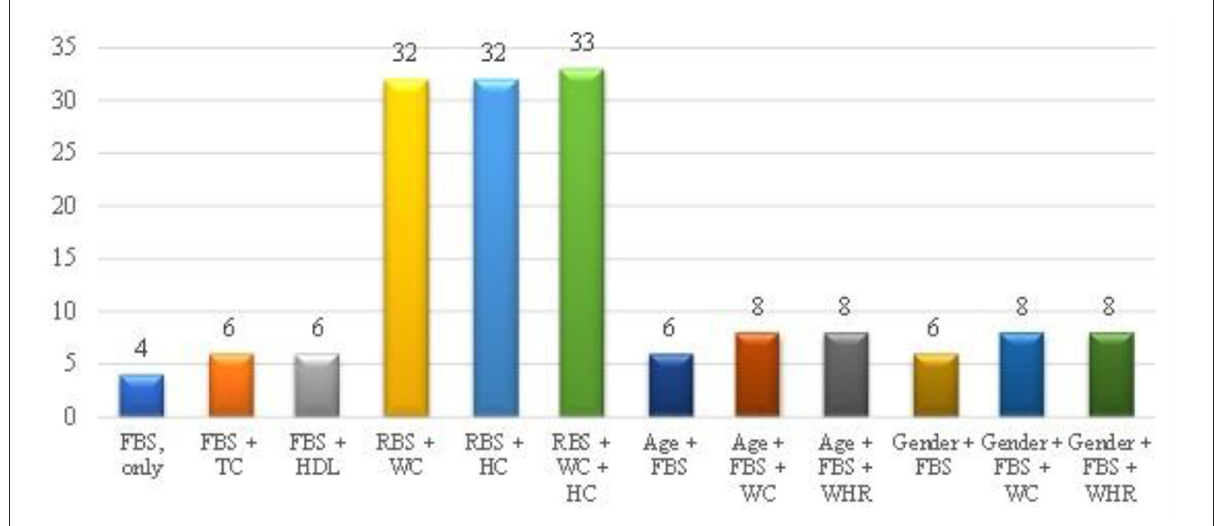
FIGURE1 Modeling of anthropometric as well as biochemical variables and ODI scores of the overall study population. FBS (FBG), Fasting blood glucose; TC, Total cholesterol; HDL, High density lipoprotein; RBS, Random blood sugar; WC, Waist circumference; HC, Hip circumference; WHR, Waist-to-hip ratio. The y-axis of this figure represents the AIC value, while x-axis represents the parameters.